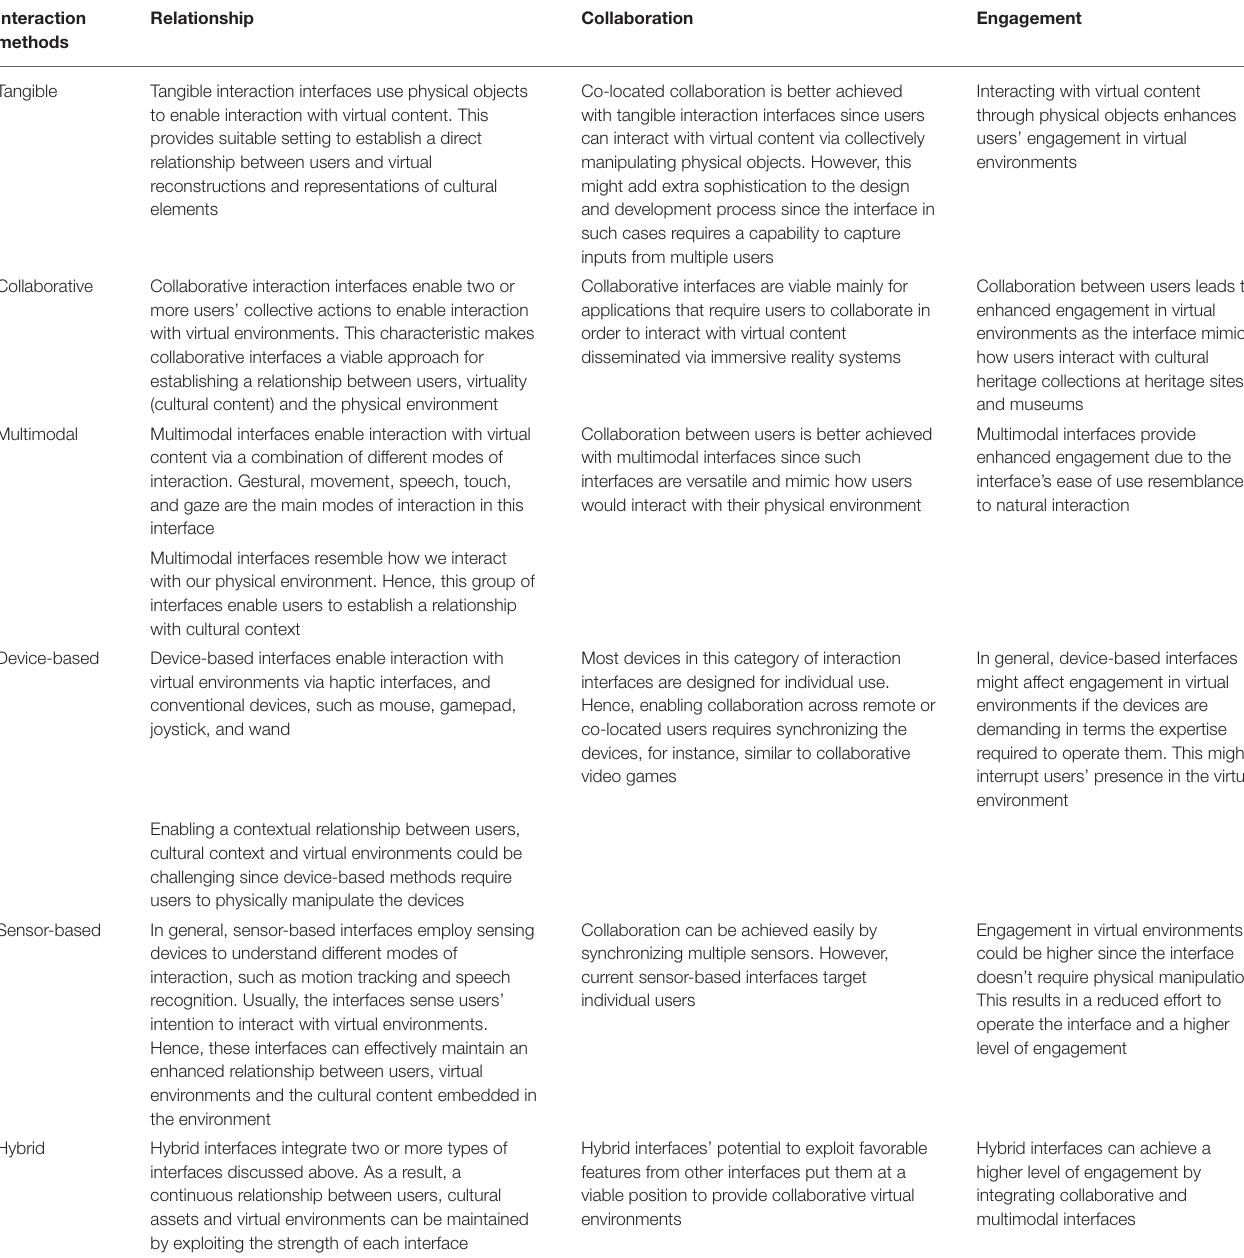
TABLE 4 | A comparison of different categories of interaction interfaces against relationship, collaboration, and engagement: the comparison assists predetermining the relevance of a given interaction interface to enable cultural learning in virtual heritage applications. Interaction